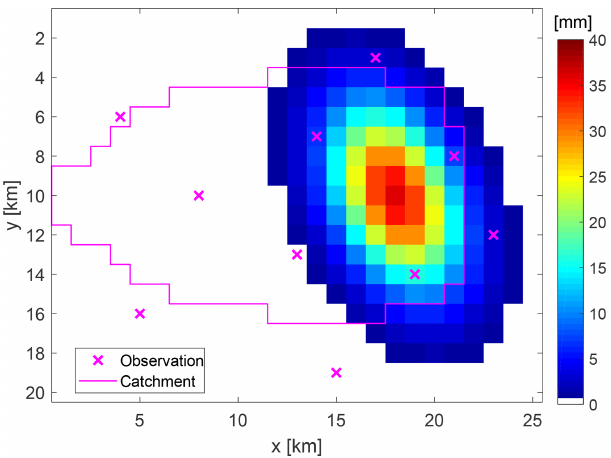
Figure 3. Rainfall amounts of the synthetic rainfall event. Virtual monitoring stations are marked by